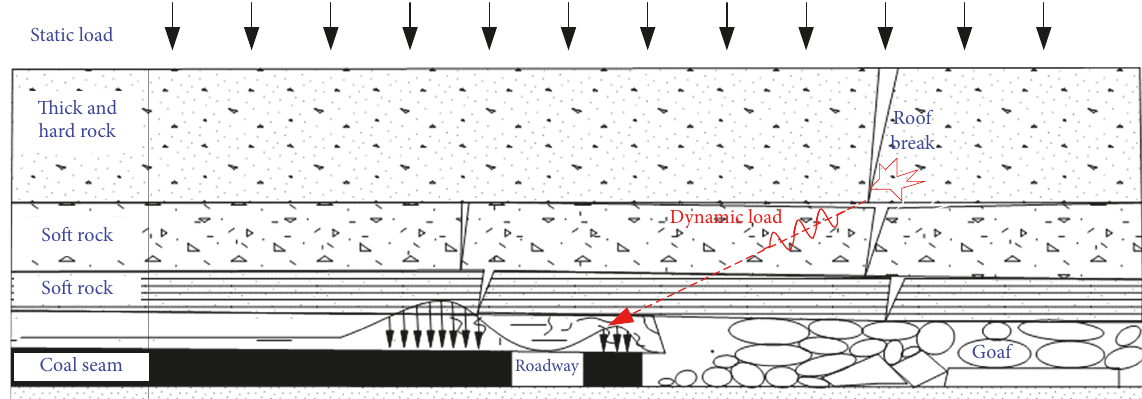
Figure 1: Rock burst induced by breaking of hard roof